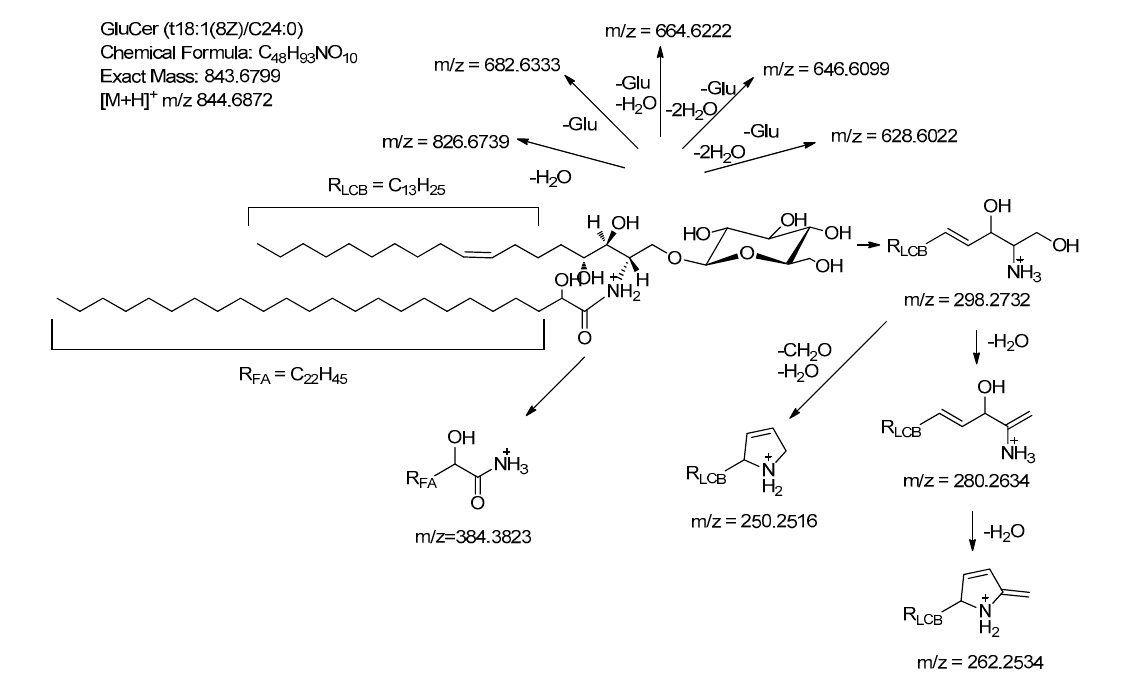
Figure 2. MS and MS/MS spectra of compound 13 .